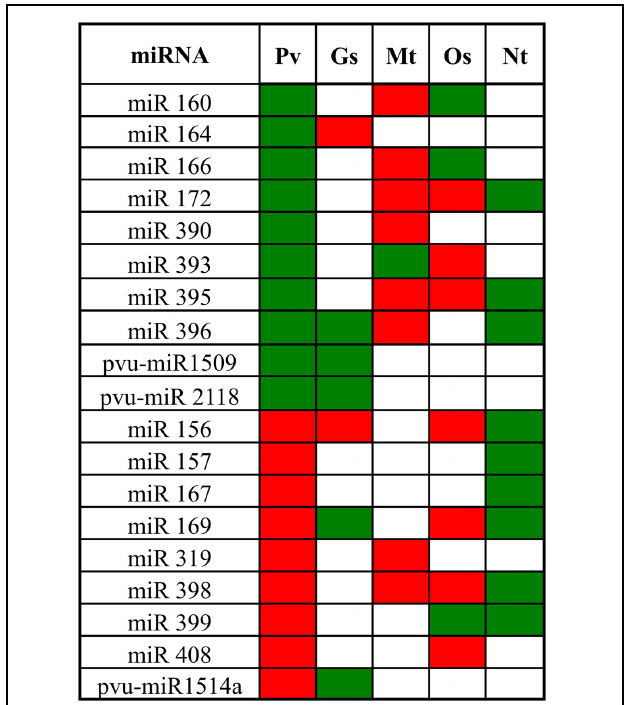
FIGURE 6 | Alt-responsive microRNAs from several plant species. Pv, Phaseolus vulgaris , Gs, Glycine soja , Mt, Medicago truncatula, and Nt, Nicotiana tabacum . Green, up-regulation and red, down-regulation. References: Zhou et al. (2008), Lima et al. (2011), Burklew et al. (2012), Chen et al. (2012), and Zeng et al.